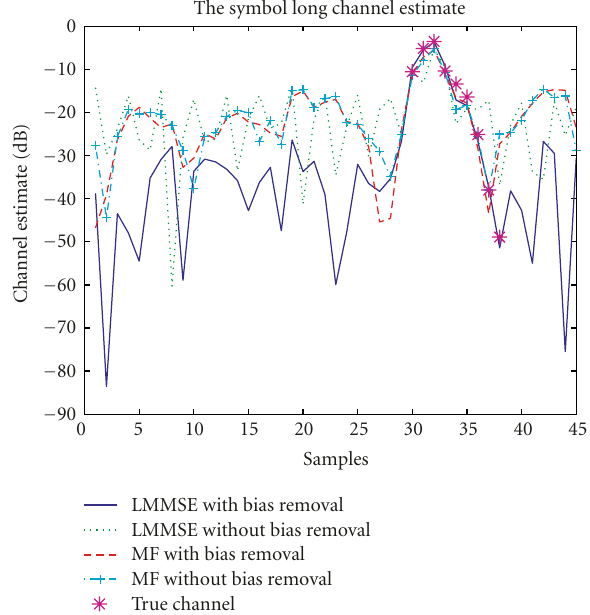
Figure 5: The symbol-long channel estimate h δ with bias removal and | h ssδ (1 : L s ) | without bias removal, when SNR is